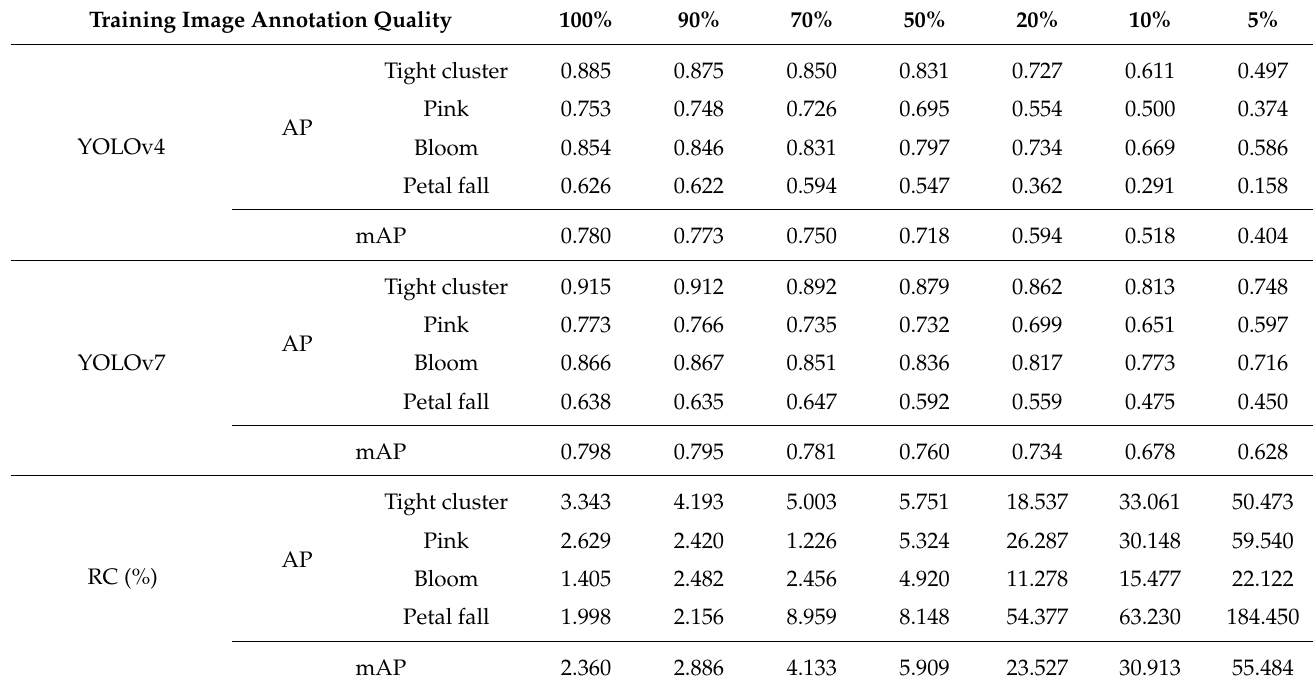
Table 2. YOLOv4 and YOLOv7 model performance comparison based on the validation dataset. Training Image Annotation